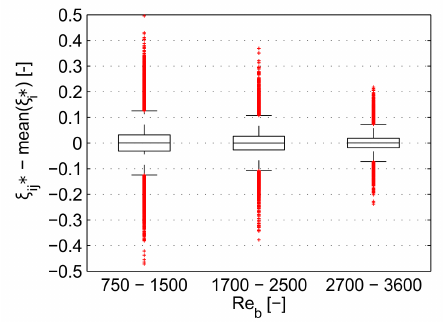
Figure 5. Head loss coefficients ξ ∗ calculated for each data point ( j = 1–2700) subtracted by the mean ij value of ξ ∗ of each measurement for three ranges of Bar–Reynolds number Re b . i